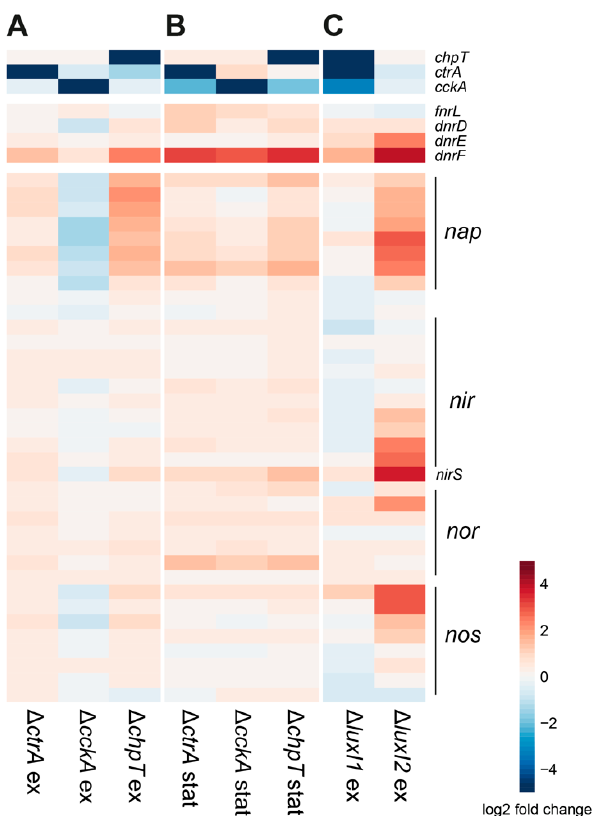
Figure 2. Comparison of CtrA phosphorelay, Crp/Fnr regulator, and denitrification gene expression control by CtrA phosphorelay and LuxI 1/2 synthases during exponential and stationary growth phases. Samples for the ctrA , cckA , and chpT knockout mutants were analyzed at mid-exponential (OD 0.4) ( A ) and stationary (six hours after onset of stationary phase) ( B ) phases of growth. The Δ luxI 1 data were obtained during stationary phase, six hours after the onset of stationary phase, and the ∆ luxI 2 data were obtained during the mid-exponential growth phase ( C ).